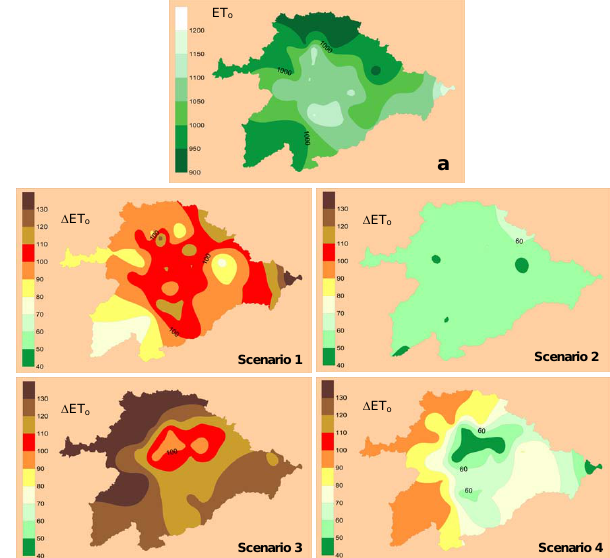
Fig 2. a, Annual ET (mm) for reference year 2007 and increases ( Δ ET , mm) by 50 ( 1 ET o , mm) by 50yr according to scenarios 1, 2, 3 and years according to Scenarios 1, 2, 3 and 4.